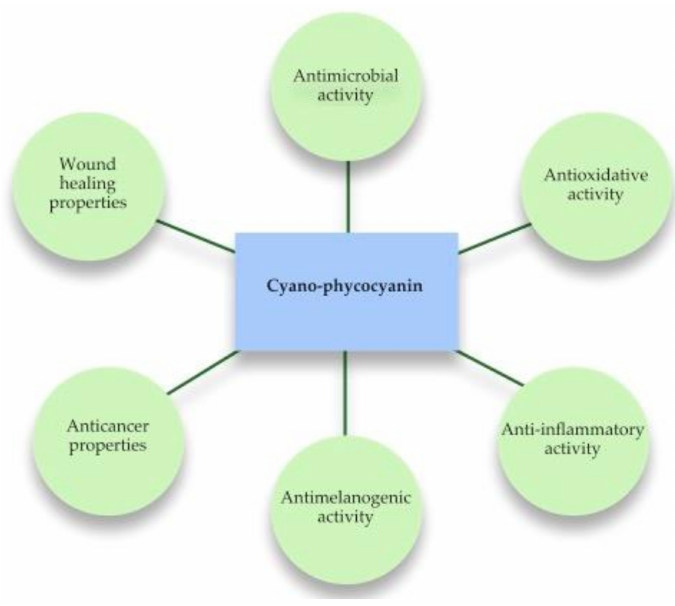
Figure 1. Physiological properties of C-PC for the topical